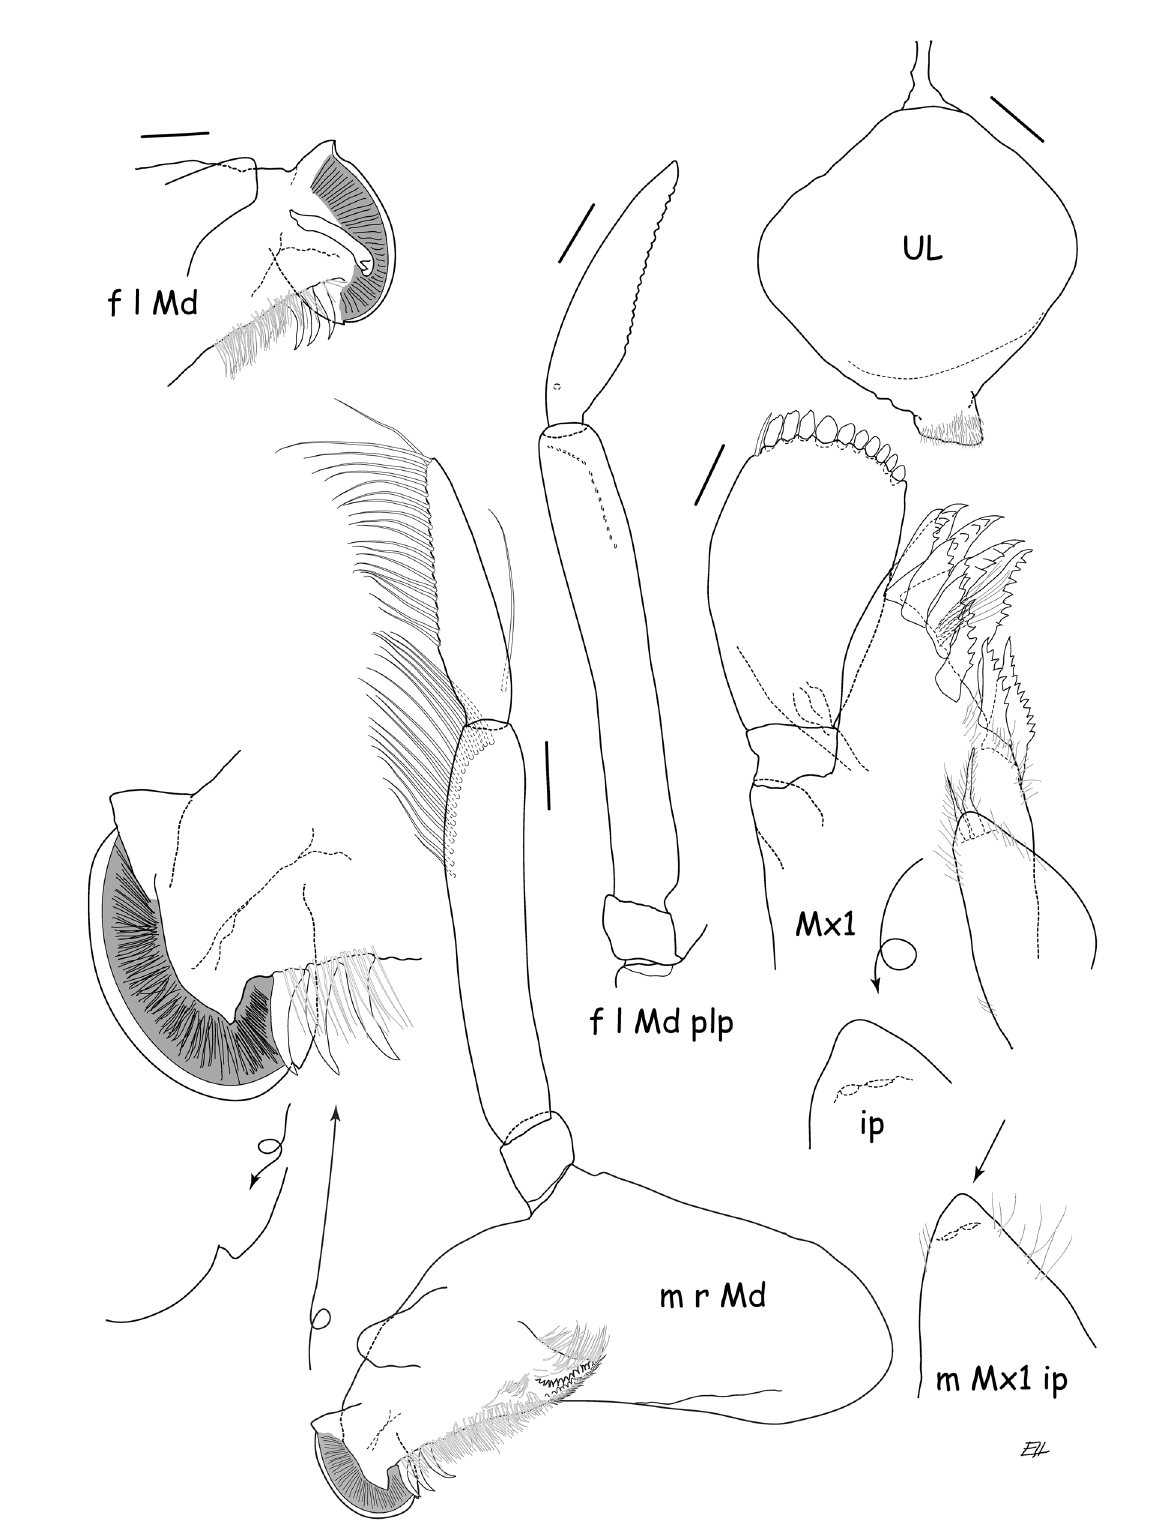
Fig. 12. Abyssorchomene patriciae sp. nov., holotype, ♀, 10.5 mm (NHM UK 2022.6); allotype, ♂, 7.5 mm (NHM UK 2022.7). Setae omitted on female left Md palp. Figures with sex not indicated are of female. Scale bars = 0.1